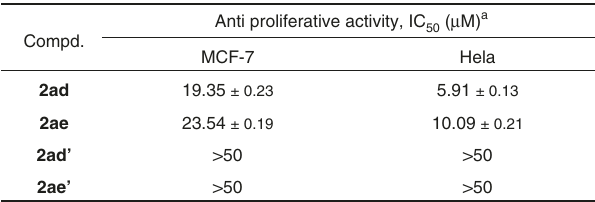
Fig. 4 In vitro antiproliferative activities of compounds 2ad, 2ae, 2ad ’ , and 2ae ’ . a Concentration that inhibits the proliferation of cancer cells by 50%. Cell proliferation was measured using the CCK8 assay after incubation with the compounds for 24 h. The mean values of three independent experiments ± SE are